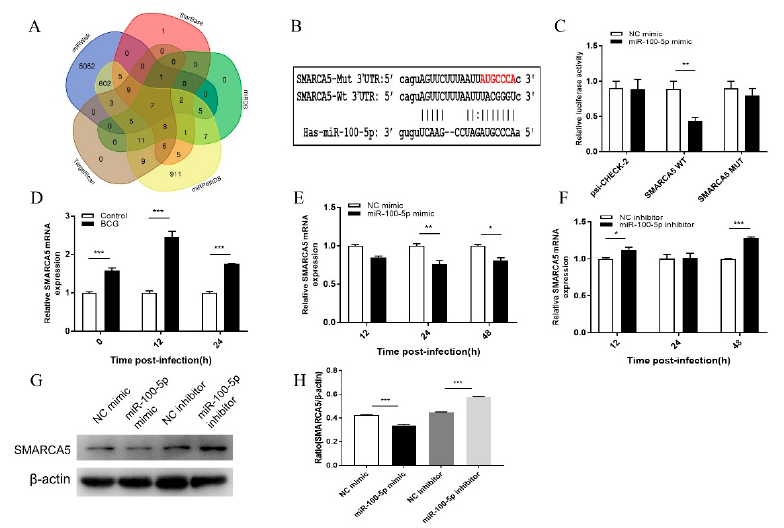
Figure 6. Screening and validation of miR-100-5p target genes. ( A ) miR-100-5p target gene prediction with five software and analyzed by Venn diagram. ( B ) Binding site of miR-100-5p with SMARCA5 WT or mut 3 ′ -UTR as predicted by online prediction software. ( C ) Dual-luciferase re- porter assay performed in HEK 293T cells. miR-100-5p mimic or NC mimic was cotransfected with dual-luciferase reporter plasmids, such as psiCHECK2 control, psiCHECK2-SMARCA5-wt, and psiCHECK-SMARCA5-mut. The ratio represents the Renilla to firefly (Rluc/Fluc) ratio in miR-100-5p mimic versus NC mimic. ( D ) Differential SMARCA5 expression between BCG-infected (MOI = 10) and uninfected cells measured by qRT-PCR at 0, 12, and 24 hpi. ( E , F ) THP-1 cells were transfected with NC mimic, miR-100-5p mimic, NC inhibitor, or miR-100-5p inhibitor for 24 h and infected